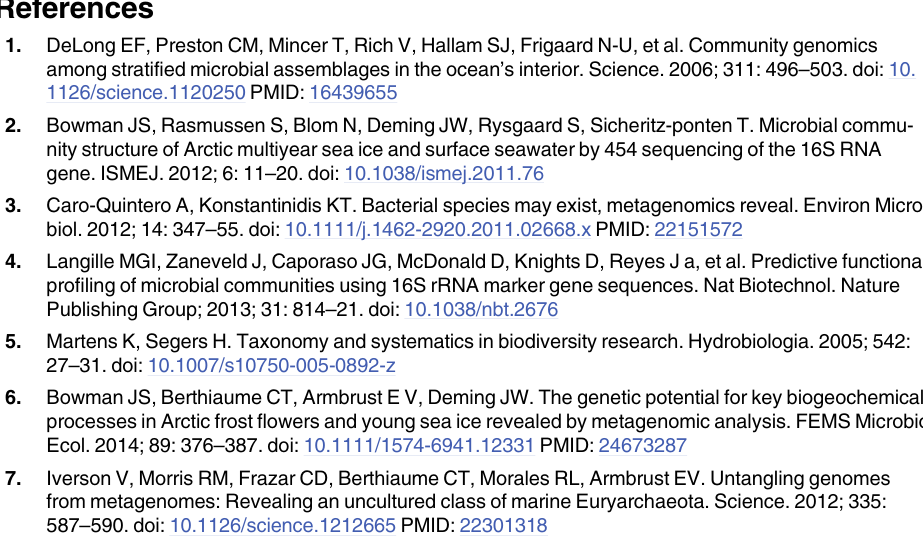
S2 Fig. 16S rRNA gene distance as a function of reduced compositional vector distance. S3 Fig. Square matrix of normalized residuals. Each row (or column) is a published complete genome. Row means (Fig 2) are a measure of genomic plasticity. White color is centered on the mean for the normalized residuals of 0.32. Blue values are pairwise comparisons where the pre- dicted 16S rRNA gene distance was less than the observed, red values are pairwise comparisons where the predicted 16S rRNA gene distance was greater than the observed. S1 File. Unrooted tree used for phylogenetic placement. The tree shown is for sample sum- mer_sw_shallow_b.1, edges are fattened to show the relative number of placements to each edge. The tree is in the PhyloXML format. S2 File. Rooted reference tree without numbered edges. Terminal node order on this tree corresponds to the order given in Fig 1. Tree is in the Newick format and can be opened with a standard tree viewer. S3 File. Tab-delimited file of pathways predicted for each